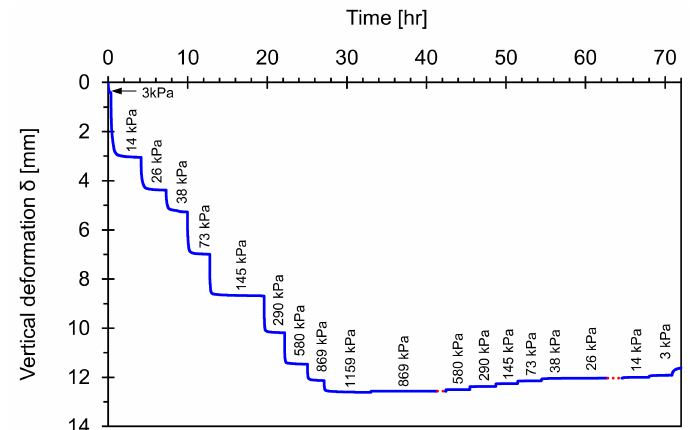
Figure 8. Load-deformation response for original field sample under zero-later strain conditions.